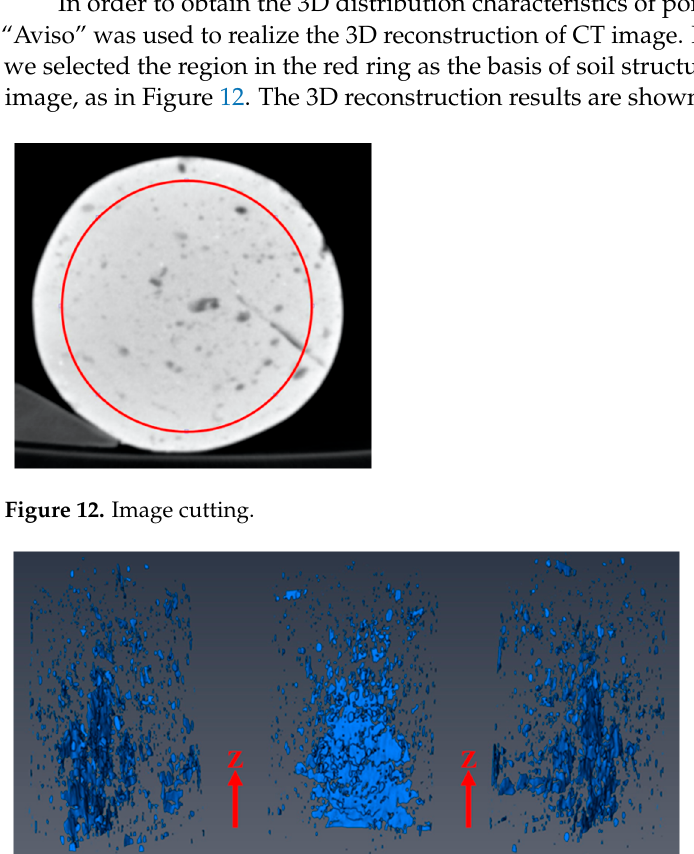
Figure 11. Dry density obtained by cutting ring method.